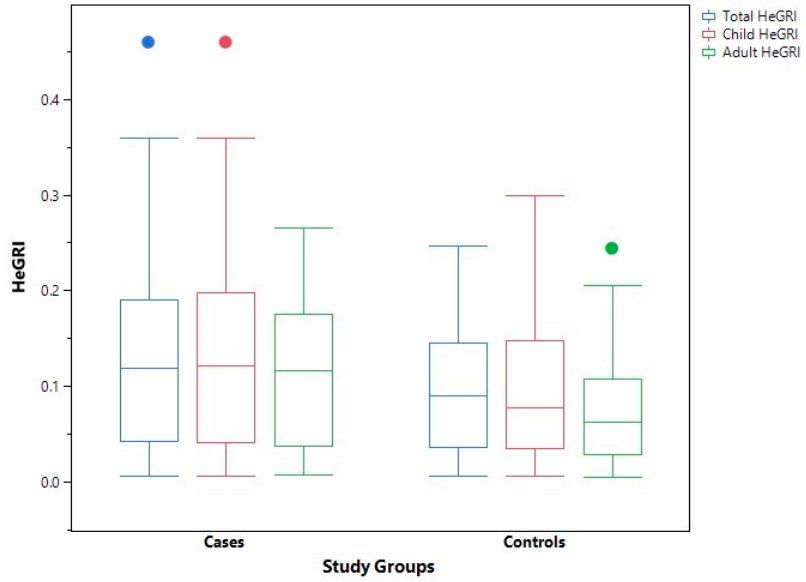
Figure 2. Comparisons of HeGRI indicators between cases and controls. Table 4. Comparison of hepcidin, hepcidin/ferritin and hepcidin/eGFR ratio between controls and cases